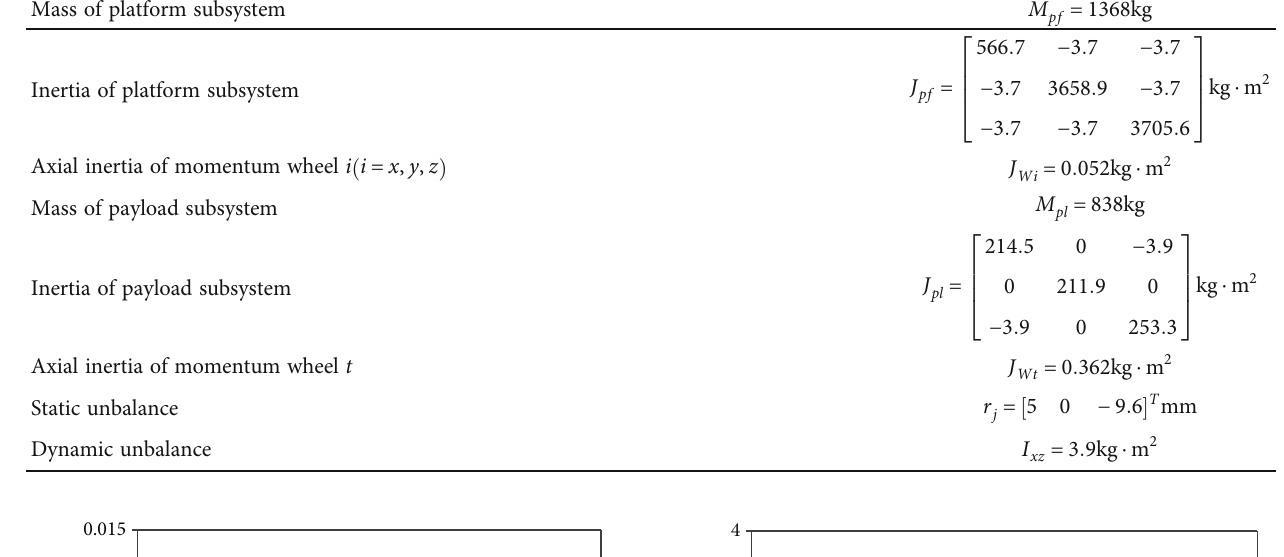
Table 3: Parameters of the RPS